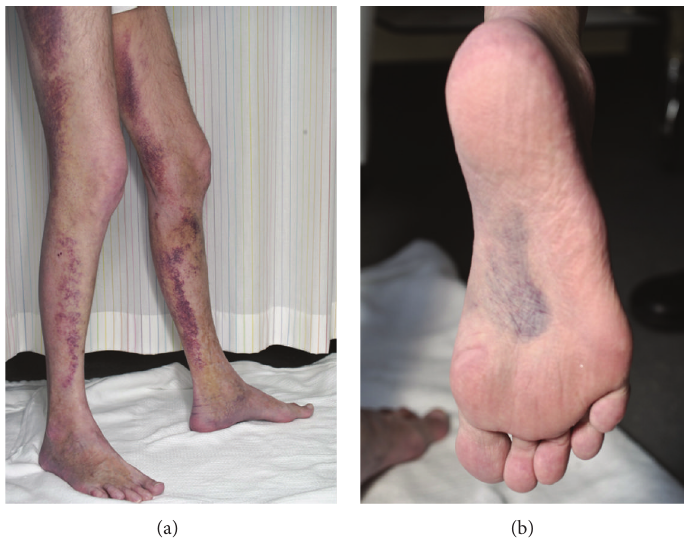
Figure 1: Palpable, purpuric rash and confluent ecchymoses on both legs and in the soles.